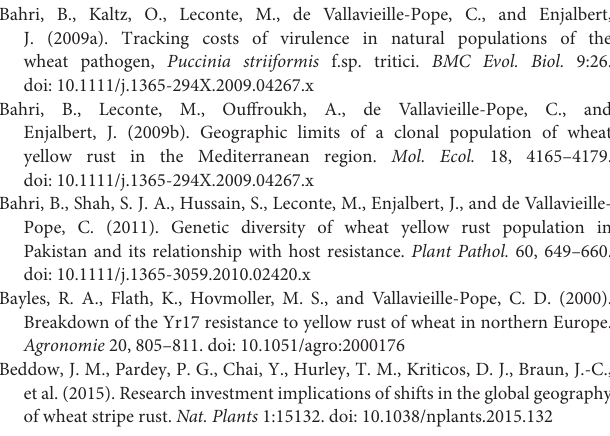
Table S6 | Overview of Yr resistance genes deployment across different geographical regions worldwide, considering epidemics associated with deployment of various